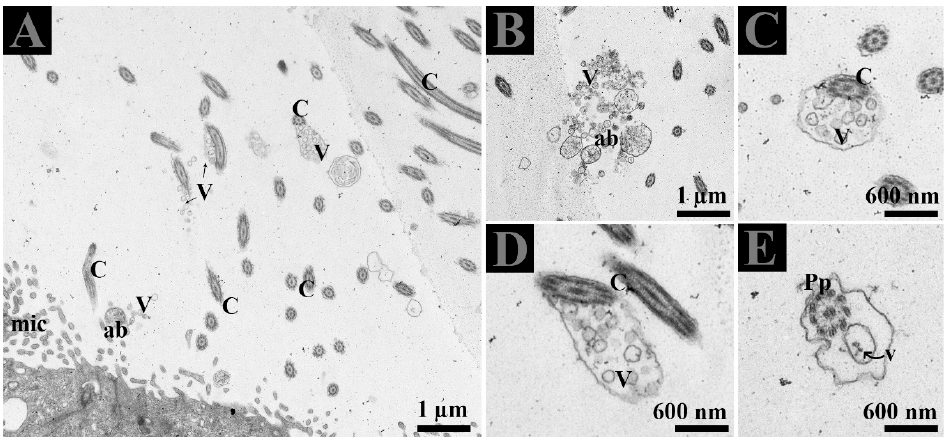
Figure 5. ( A – E ) Ultrastructure of extracellular vesicles and the principal piece of spermatozoa within the lumen of DE. Ab: apical blebs; C: cilia Mic: microvilli: Pp: principal piece of spermatozoa; V: vesicles. Scale bar: A–B: 1 µm; C–E 600 nm.